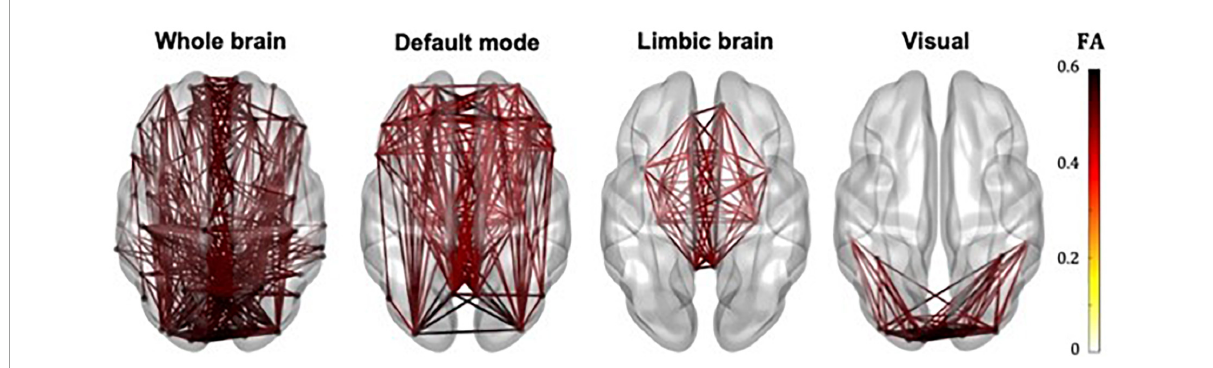
FIGURE4 Whole-brain, DMN, limbic and visual subnetworks, for FA-weighted networks, from the data of one participant. The lines represent the edges (connections) between brain